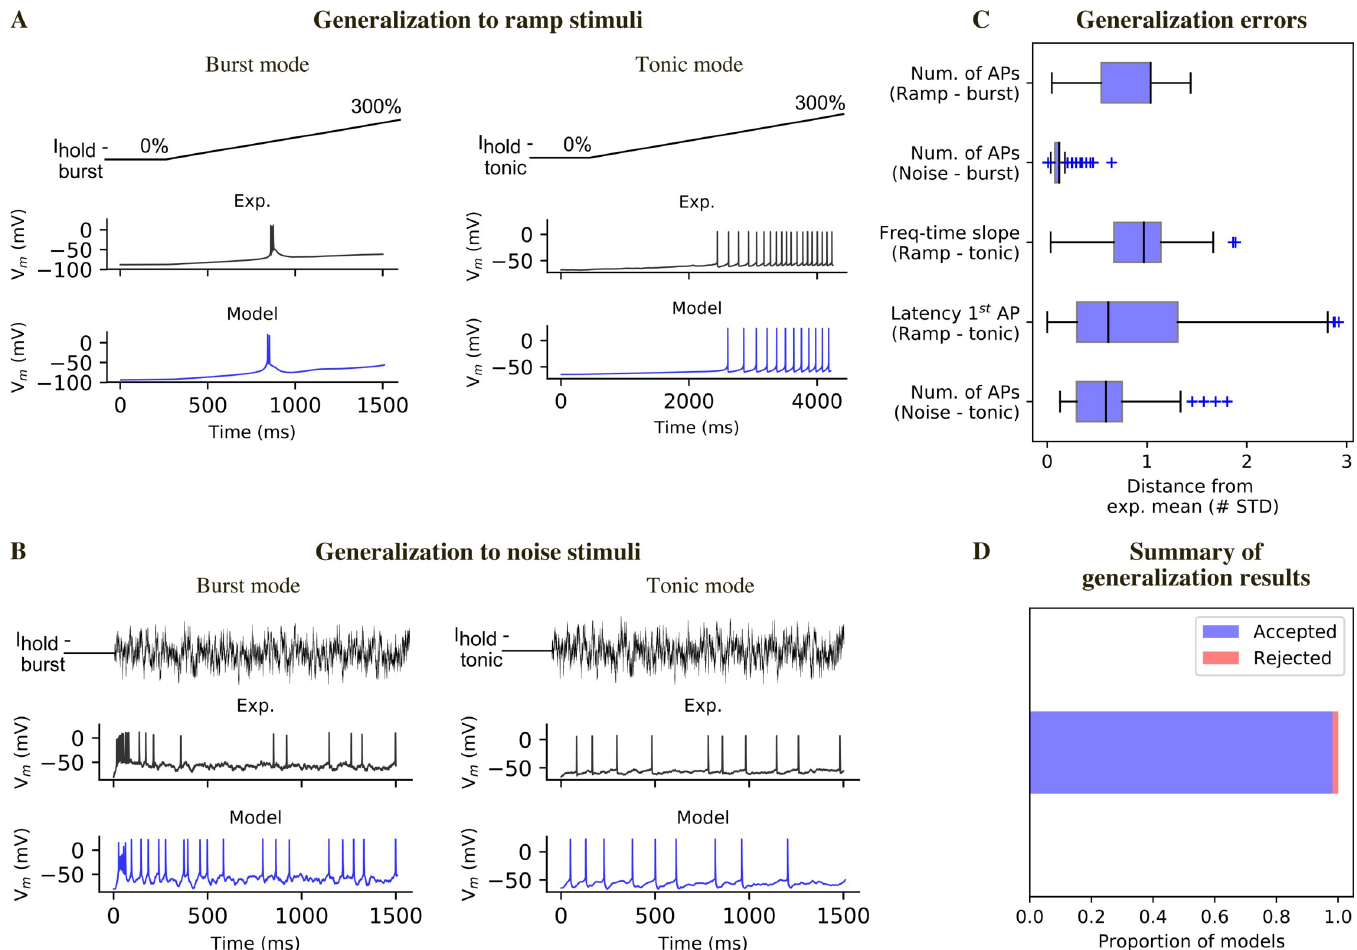
Fig 6. Model generalization. (A) Responses to a ramp current injection in burst mode (left) and tonic mode (right). (B) Responses to a noise current generated according to an Ornstein-Uhlenbeck process and scaled based on the excitability of the different experimental cells and models (see Methods). (C) Generalization errors for all the models that passed the generalization test (all generalization errors < 3 STD). (D) Proportion of models that passed the generalization test (see S4 Fig for examples of models that failed this test).